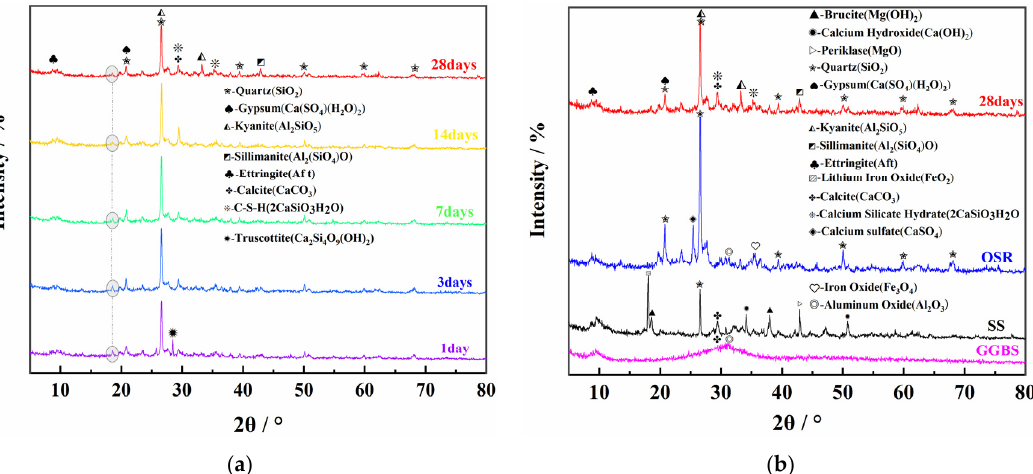
Figure 8. XRD patterns of COSGB before and after reaction: ( a ) COSGB at different curing ages and ( b ) OSR, SS and GGBS at curing ages of 28